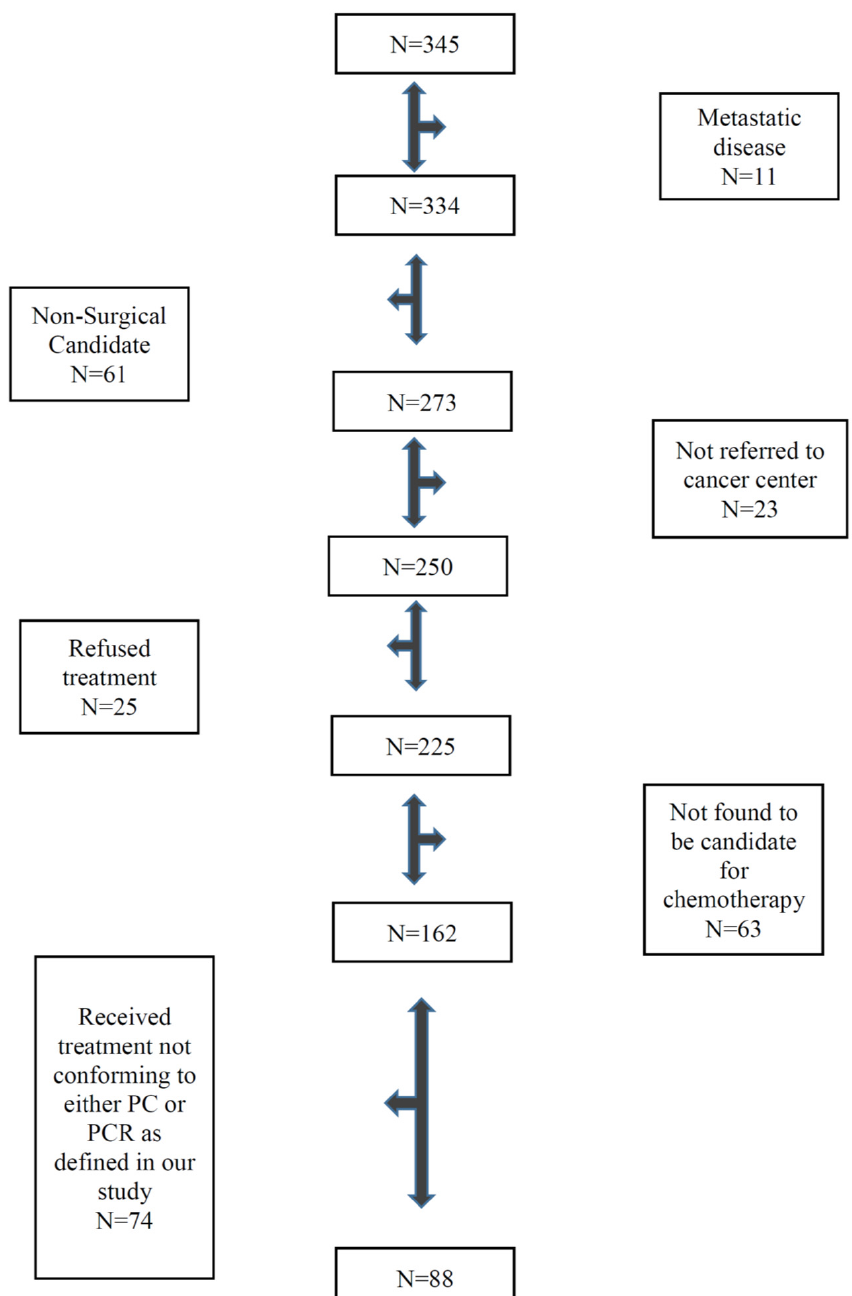
Figure 1. Flow chart showing eligible